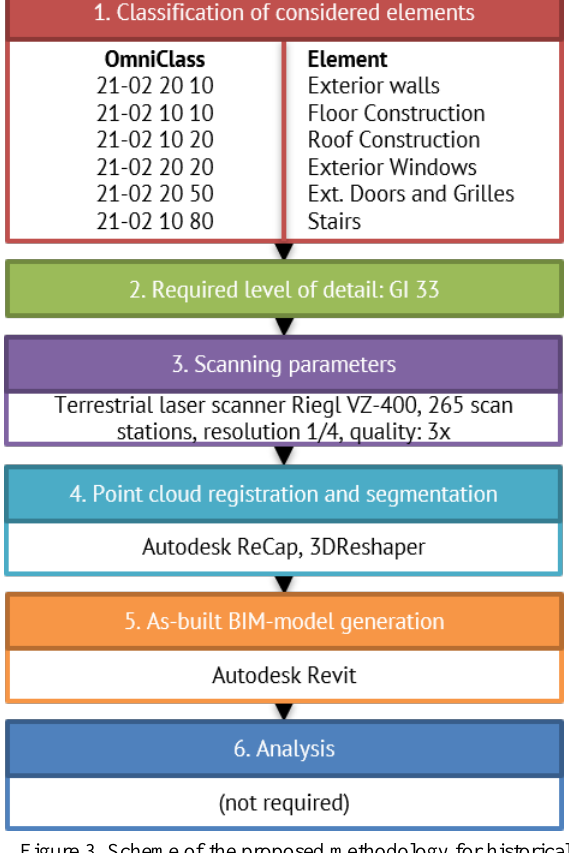
Figure 3. Scheme of the proposed methodology for historical heritage case